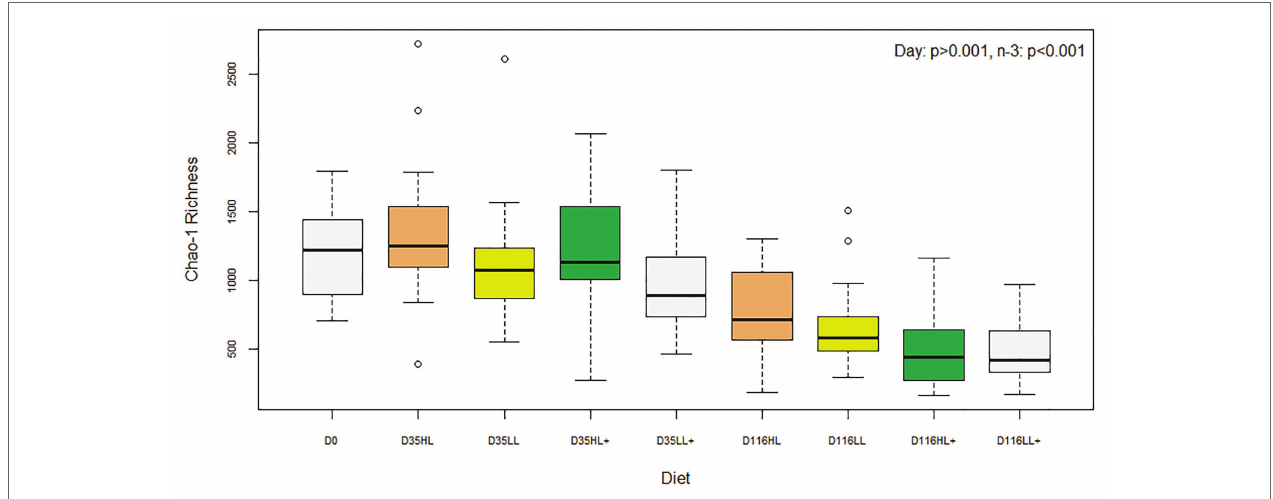
FIGURE 2 | Box plots of bacterial alpha-diversity from the distal intestine of Atlantic salmon fed HL or LL diets with or without additional n-3 PUFA (+). Oxygen conditions were pooled together and fish were sampled on day 0 ( N = 9), day 35 ( N = 72), and day 116 ( N =